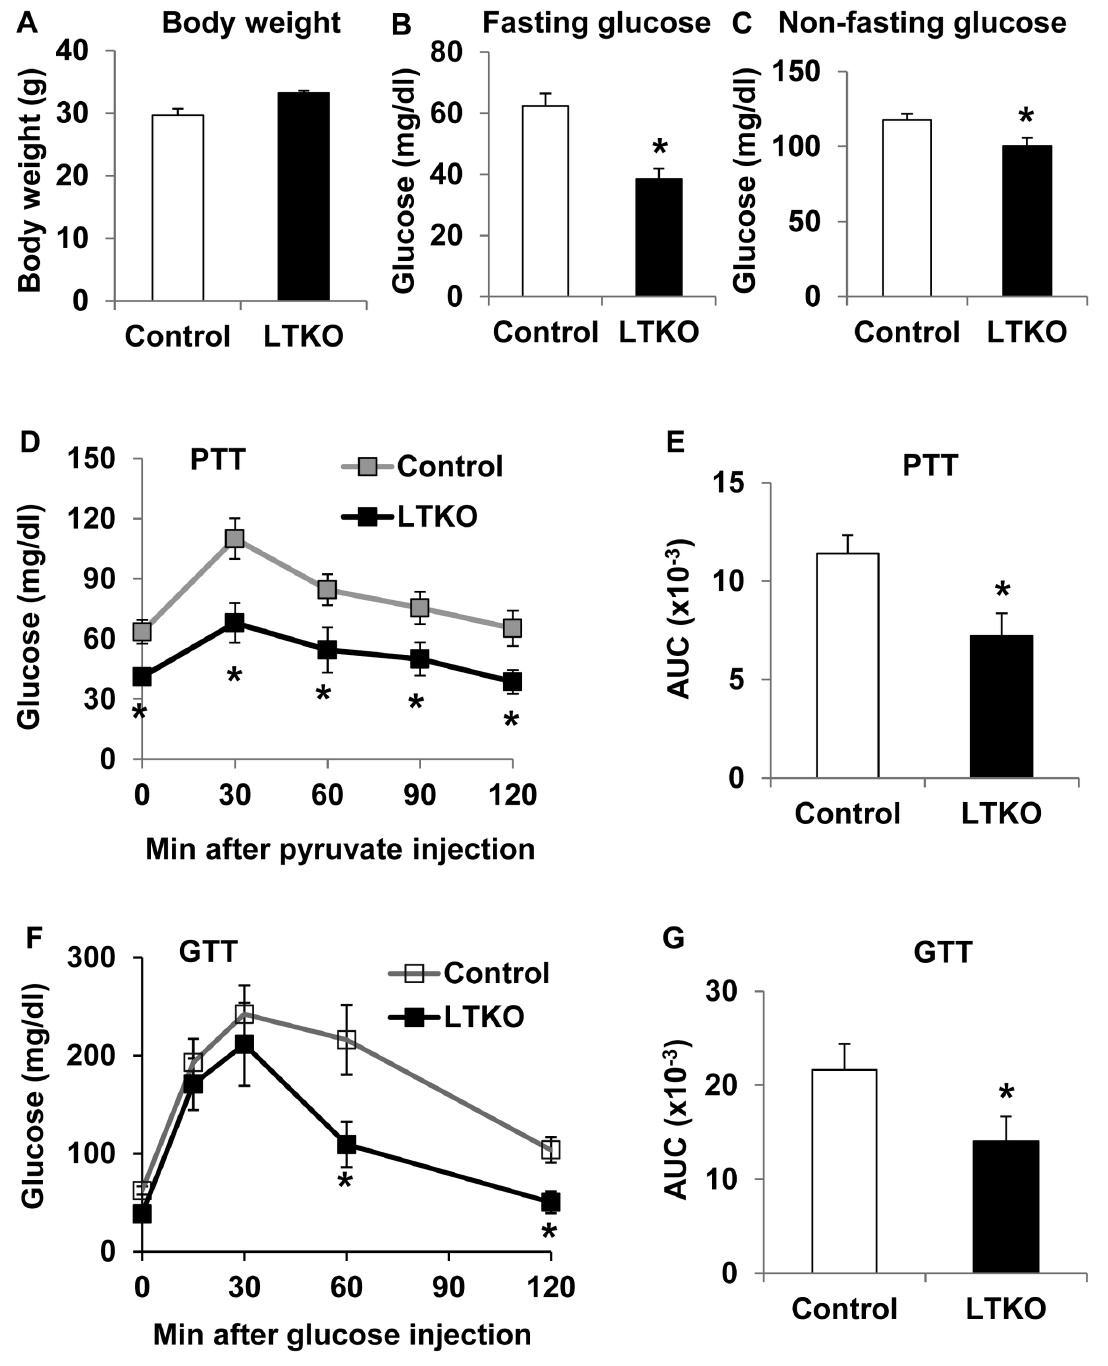
Figure 1. Glucose metabolism in the liver-specific FoxO1/3/4 knockout mice (LTKO) fed chow diet. (A) Body weight of control and LTKO male mice (n=6) at age of 4 months. (B) Blood glucose levels in 2-month male control and LTKO mice (n=6) after an overnight 16-hour fasting. (C) Non-fasting blood glucose levels in 4-month control and LTKO male mice (n=6). (D, E) Pyruvate tolerance tests (PTT) in 4-month male control and LTKO mice (n=6-7) after an intraperitoneal injection of 2 g pyruvate solution per kg body weight. The areas under the curve (AUC) in the PTT graph were also presented. (F, G) Glucose tolerance tests (GTT) in 3- month male control and LTKO mice (n=6) after an intraperitoneal injection of 2 g glucose solution per kg body weight. The areas under the curve in the GTT graph were also presented. Data represent mean ± SEM. * indicates a significance with P <0.05 in control vs. LTKO mice. doi: 10.1371/journal.pone.0074340.g001 PLOS ONE |